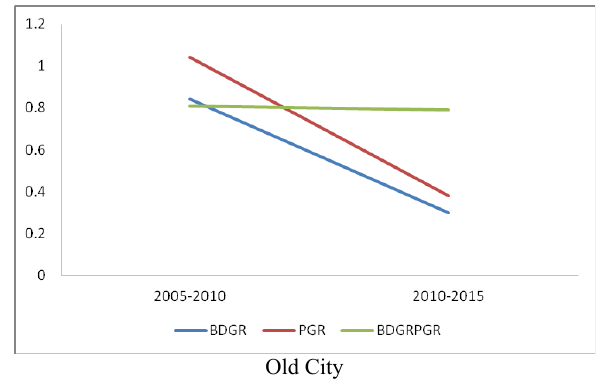
Figure 4. BDGR, PGR, BDGRPGR curves over years from 2005 to 2015 with 5 years